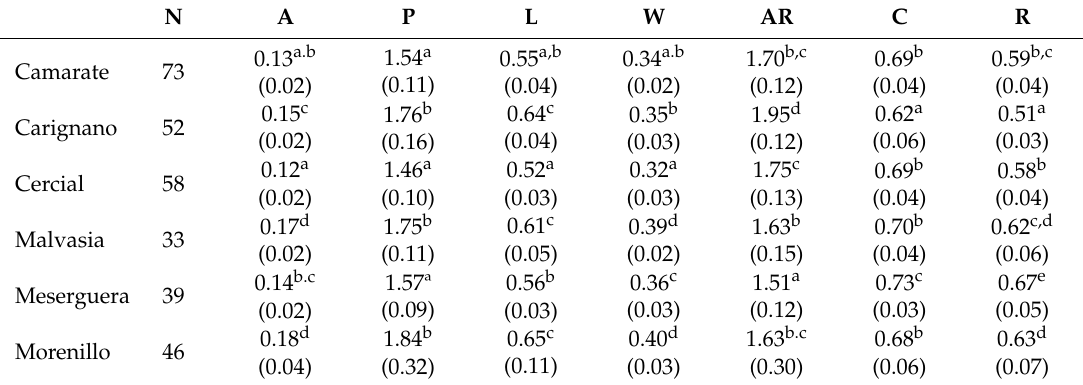
Table 2. Mean values of the area (A), perimeter (P), length of the major axis (L), length of the minor axis (W), aspect ratio (AR is the ratio L / W), circularity (C) and roundness (R), obtained for the images of the seeds of six cultivars of V. vinifera ssp. vinifera ). N